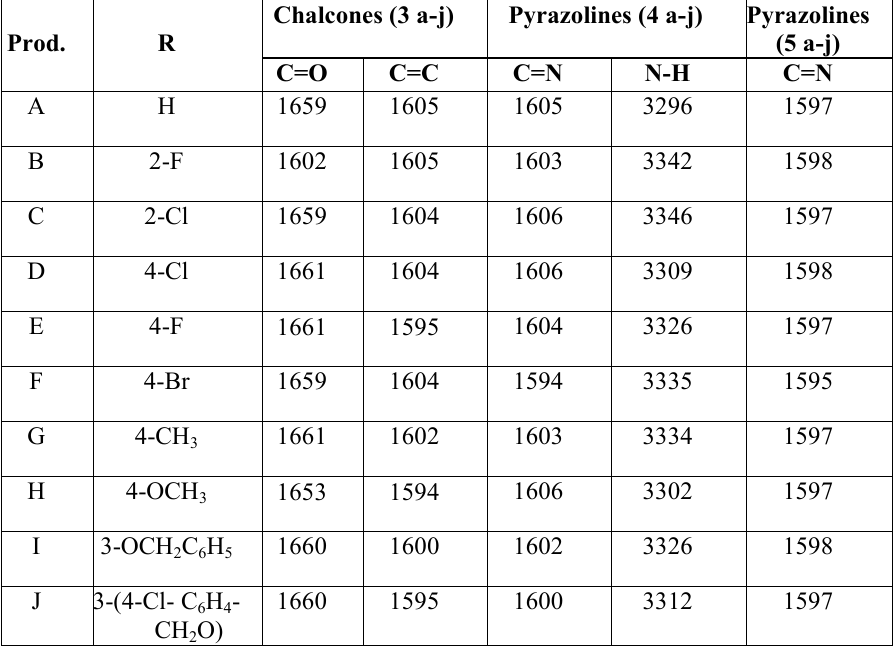
Table-4: Assignment of characteristic frequencies (cm -1 ) of IR spectra for the prepared chalcones (3a-j) and pyrazolines (4 a-j), (5a-j) . Prod.